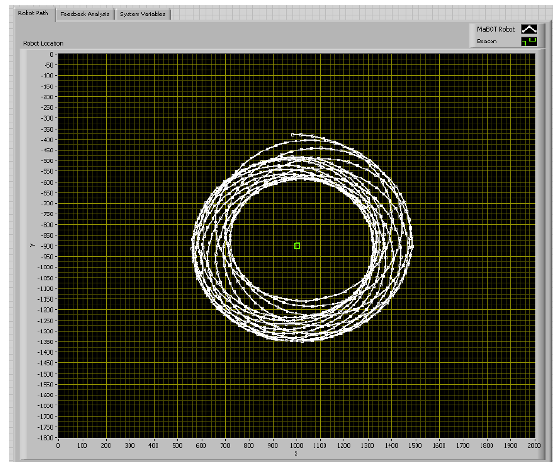
Figure 17. Robot Path tracking using the Testbed’s overhead cam- era system